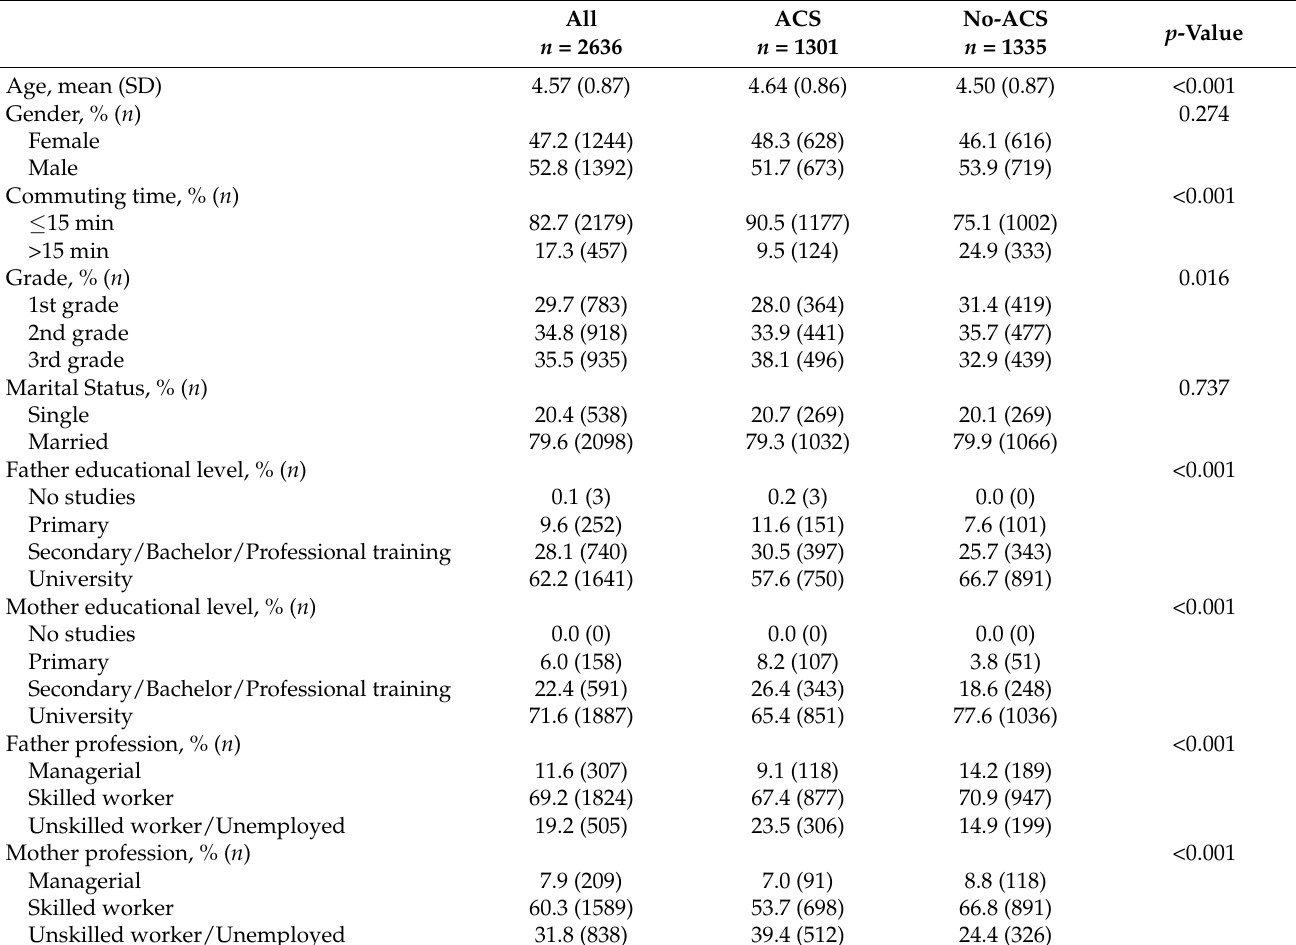
Table 1. Descriptive characteristics of preschool children and socio-economic variables, split by active commuting